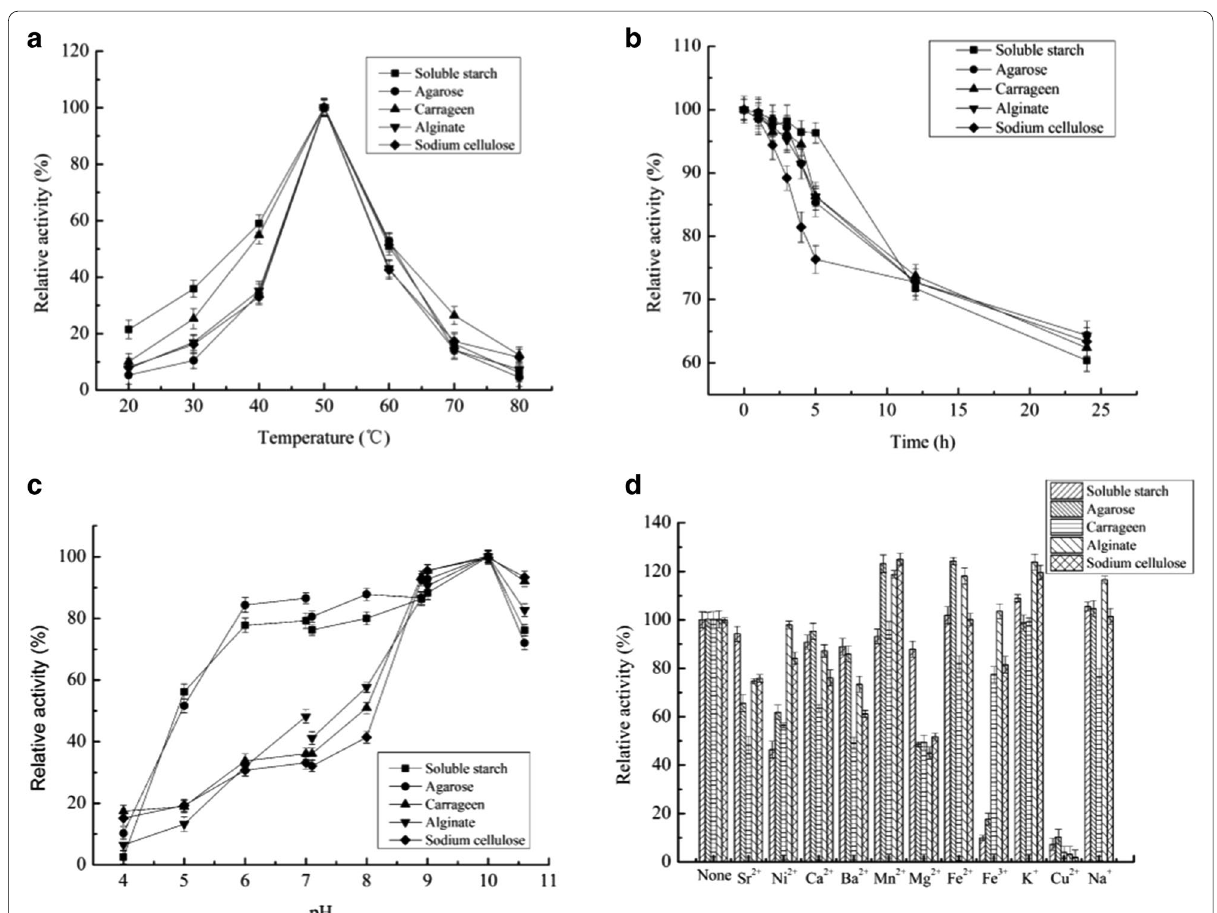
Fig. 4 Effects of temperature, pH and metal ions on the activity of Amy2587 with different substrates. a Effects of temperature on the activity of Amy2587 with different substrates; b Thermostability of Amy2587 at different temperatures and time points with different substrates; c Effects of pH on the activity of Amy2587 with different substrates; d Effects of metal ions and metal salts on the activity of Amy2587 with different